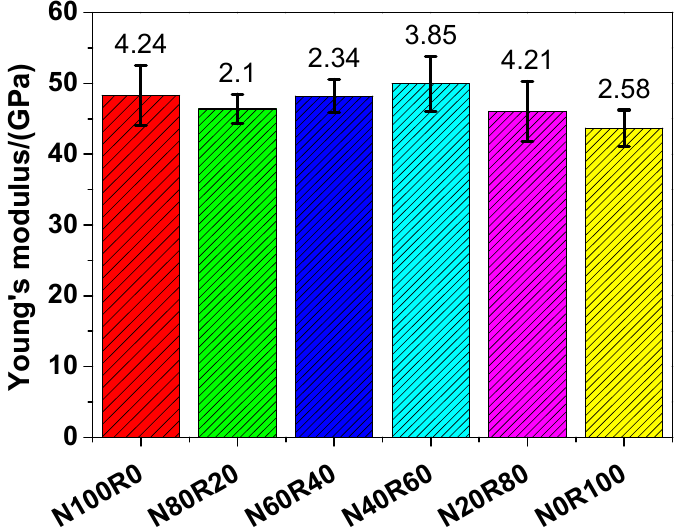
Figure 9. Young’s modulus of UHPC.